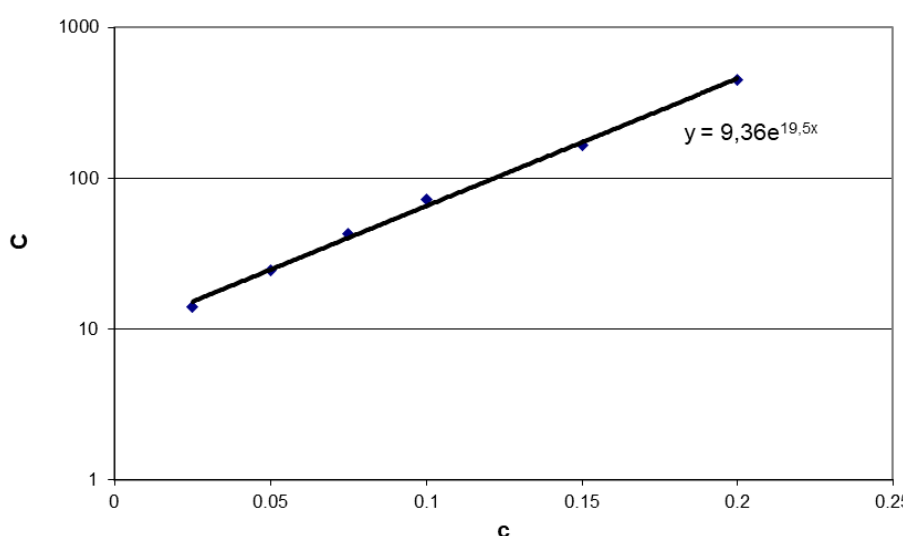
Figure 10. Plot of coefficient C on c for pitched-blade turbine.